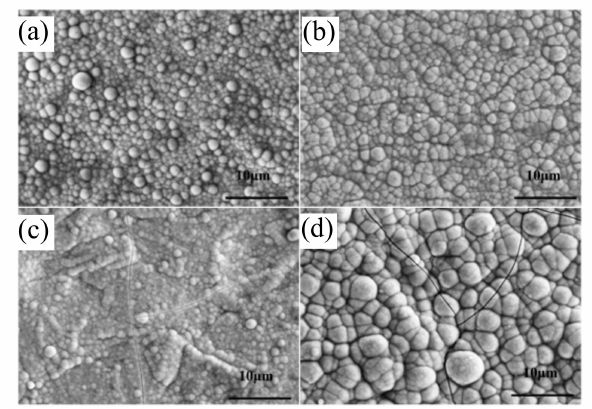
Figure 7. SEM images of the NiCrP alloy coatings at T = 30 ◦ C, D K = 15 A / dm 2 and pH = 3.5 with